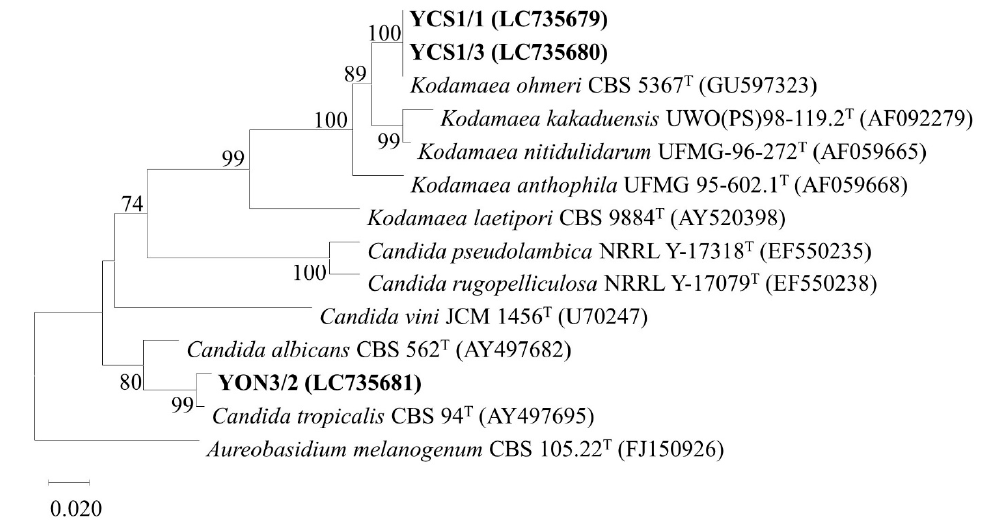
Figure 4. Phylogenetic tree based on neighbor joining analysis of D1/D2 domain sequences showing the relationship of probiotic yeast isolates. Aureobasidium melanogenum CBS 105.22 T was used as an outgroup. Numbers at the nodes indicate bootstrap values based on 1000 replicates.